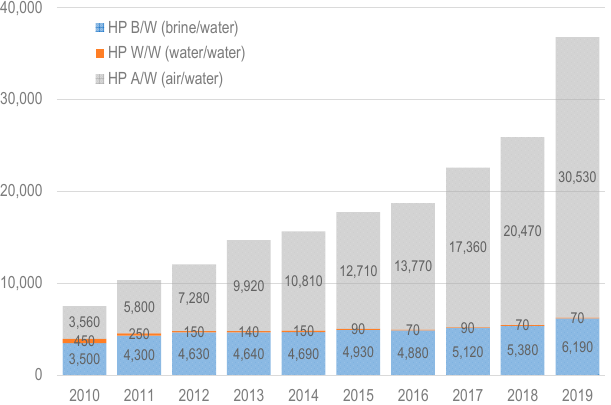
Figure 3. Heat pump sale in Poland by type of heat pump (source: [21]).